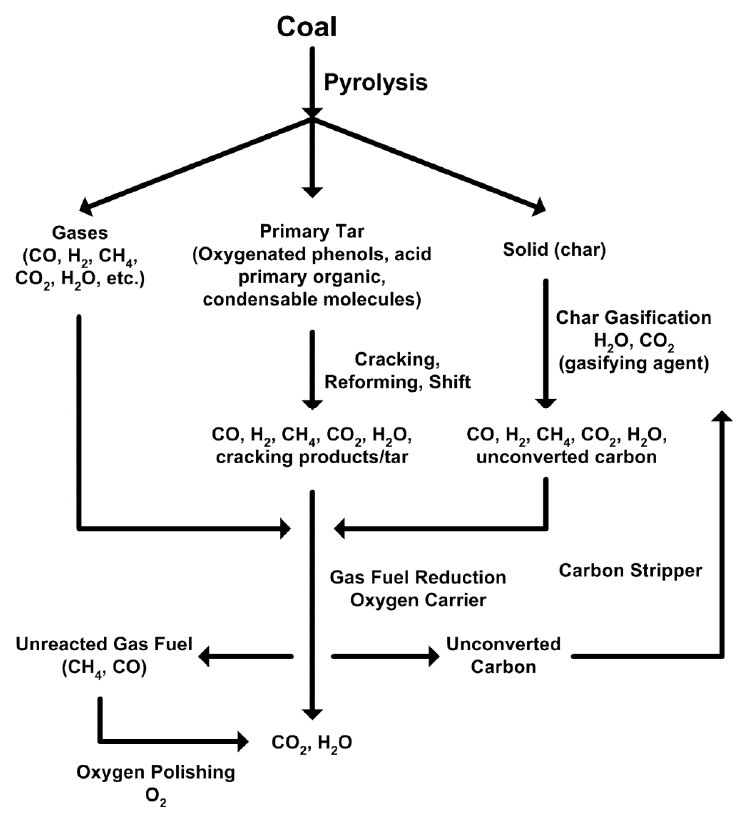
Figure 7. Coal reactions in the fuel reactor for